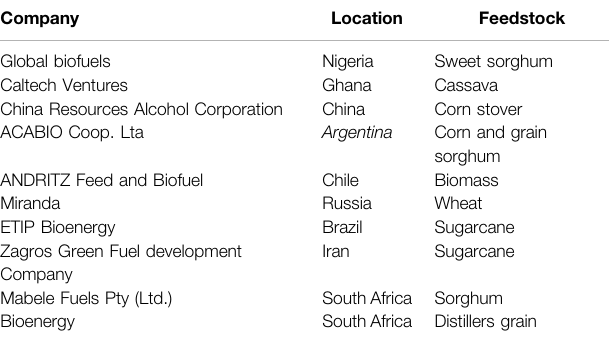
TABLE 2 | Selected biofuel producing companies, feedstock and location. Company